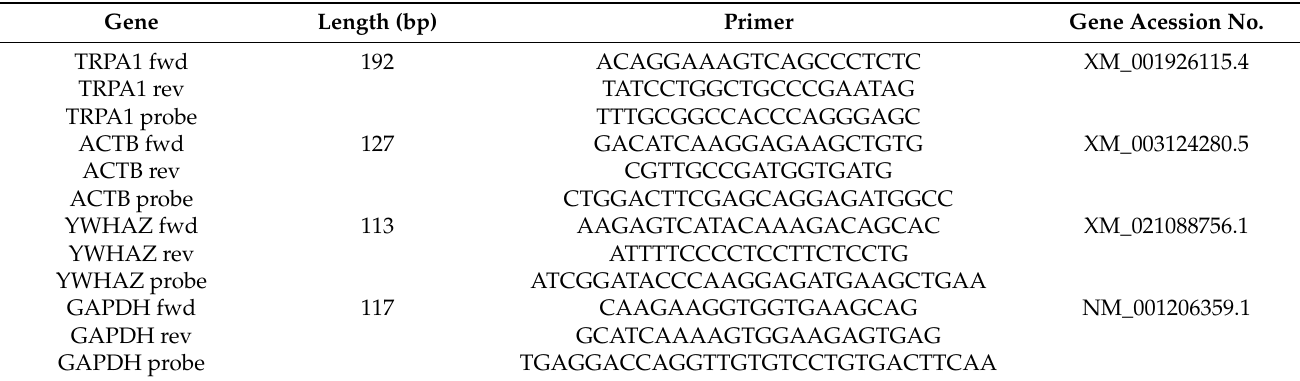
Table 3. Primer sequences and the amplicon length of the genes